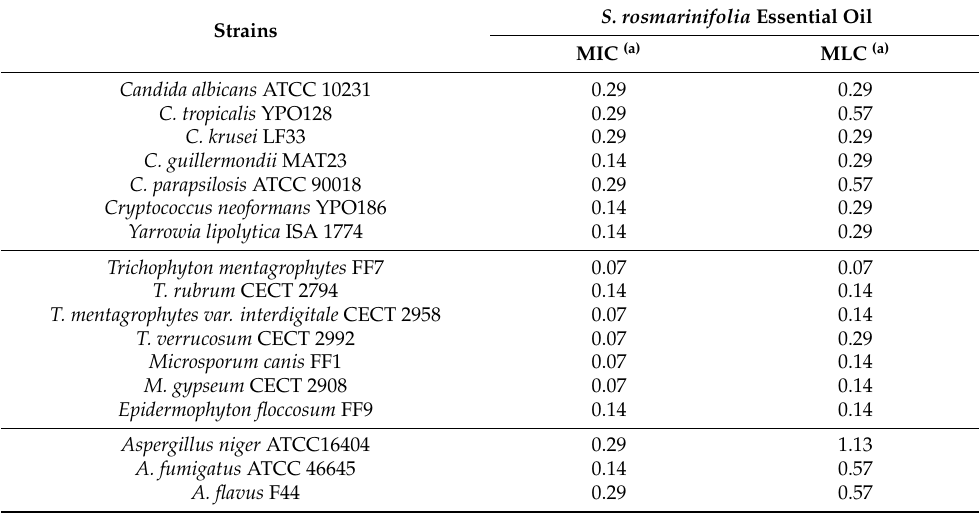
Table 2. Minimum inhibitory (MIC) and lethal (MLC) concentrations of Santolina rosmarinifolia essential oil against Candida , dermatophyte and Aspergillus strains.